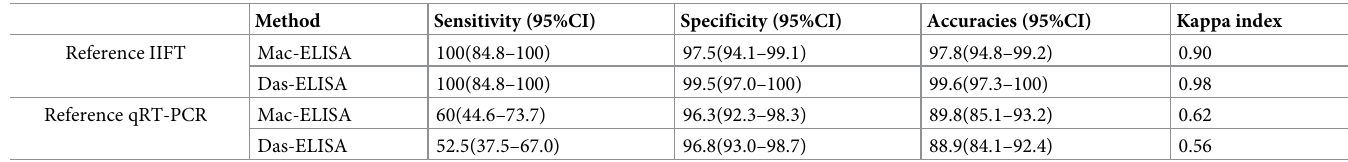
Table 5. Performance of the Mac-ELISA and Das-ELISA compared to the qRT-PCR and IIFT methods in laboratory detection of CHIKV infection.